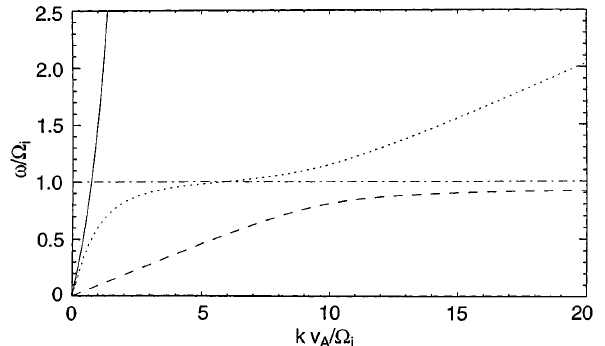
Fig. 2. The dispersion relations of the Hall-MHD. Plasma back- ground parameters: h (cid:136) 20 (cid:14) , b (cid:136) 0 : 01, v 0 (cid:136) 0. In the low frequency x limit ( x (cid:28) X i ) the branches correspond to the fast mode ( solid line ), Alfve´ n mode ( dotted line ) and slow mode ( dashed line